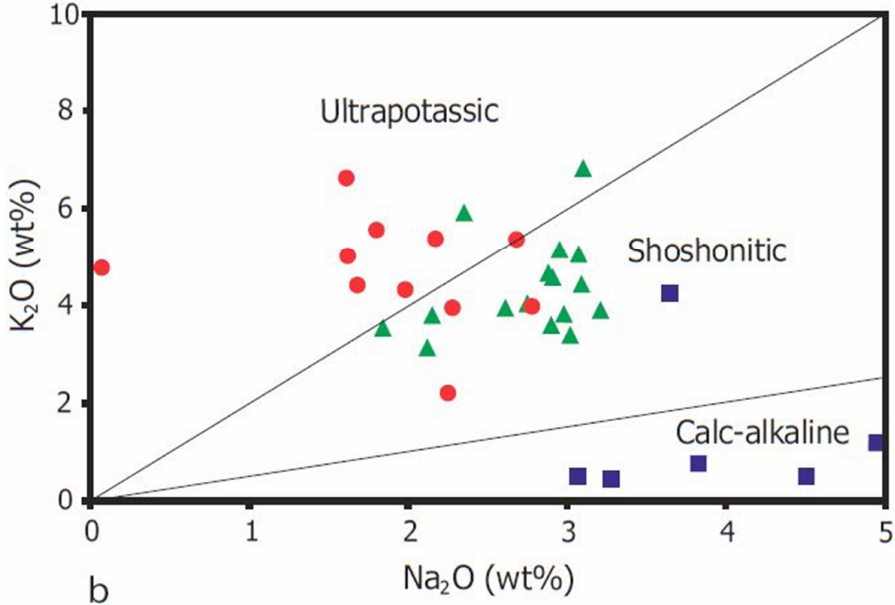
Figure 4. ( a ) Total alkali–silica diagram of Le Bas et al. [39] for Navilawa Monzonite from the Navilawa caldera. The alkalic–subalkalic line is also shown [40]. ( b ) Plot of K 2 O (wt. %) versus Na 2 O (wt. %) showing the fields of ultrapotassic, shoshonitic and calc–alkaline fields [41,42]. Data from the Navilawa Monzonite and basaltic–andesite dikes from the Tuvatu prospect taken from Scherbarth and Spry